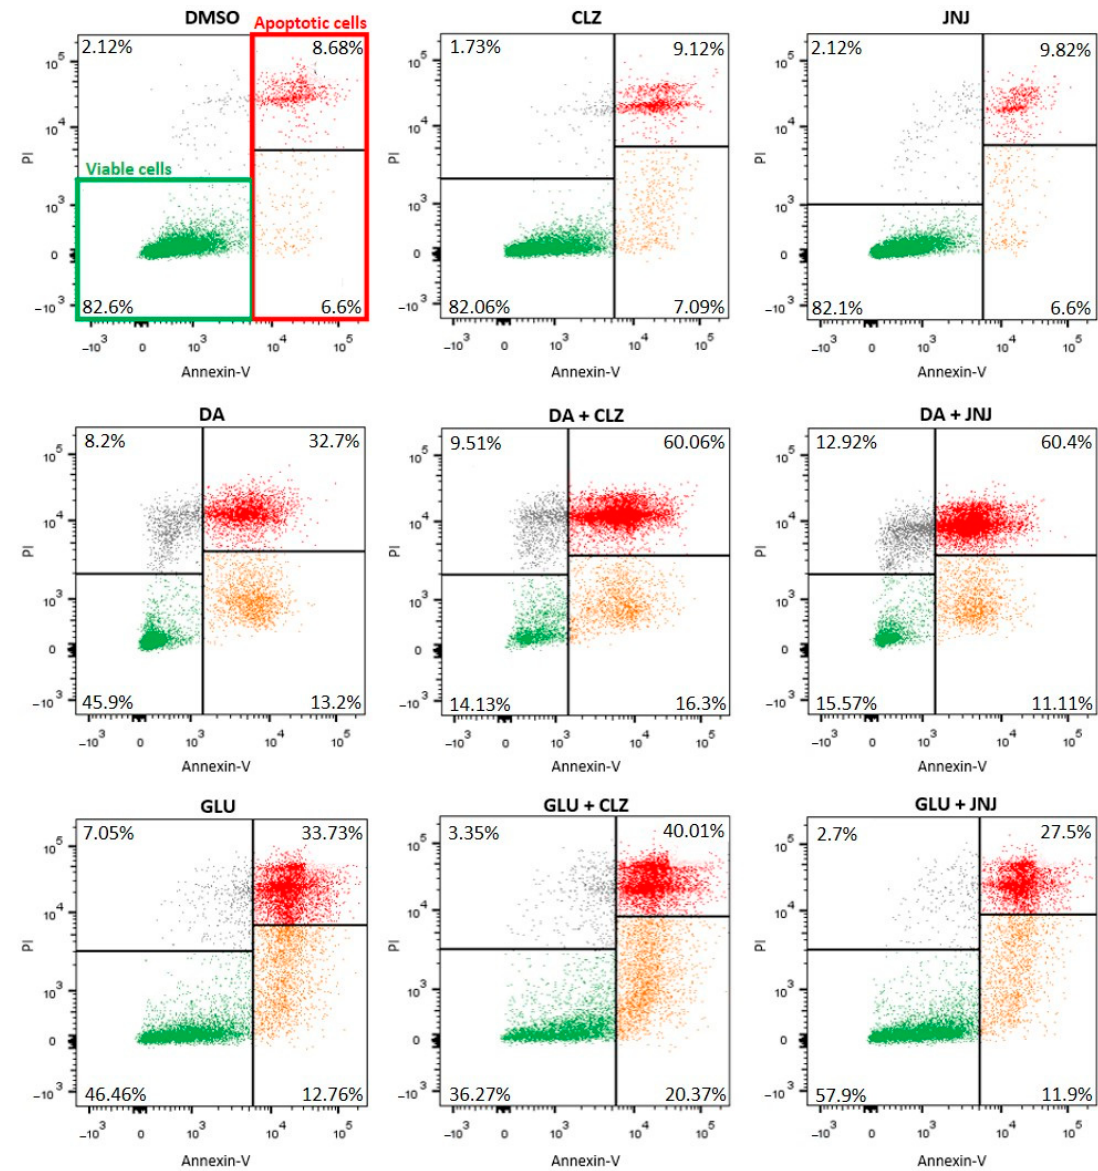
Figure 3. Representative plots showing apoptotic cell death as assessed by cytometric analysis using annexin-V/propidium iodide (PI). Dot plots represent typical results after SK-N-SH incubation with clozapine (CLZ) and JNJ-46356479 (JNJ) at the highest concentrations (25 µ M) alone or in combination with dopamine (DA) at 200 µ M or glutamate (GLU) at 160 mM. The fluorescence intensity from PI-stained cells is indicated on the y -axis, and the fluorescence intensity from cell-bound annexin-V-FITC is indicated on the x -axis. Live cells were negative for both annexin-V and PI (annexin-V–/PI–) (green cell population in the lower-left quadrant indicated by a green gate in the first representative plot), and apoptotic cells were positive for annexin-V (lower- and upper-right regions indicated by a red gate in the first representative plot). Among the dead cell population, cells positive for annexin-V and negative for PI (annexin-V+/PI − ) were undergoing the early stages of apoptosis, in which the plasma membrane is still intact, and exclude PI (orange population in the lower-right quadrant). In the late stages of apoptosis and necrosis, dying cells can no longer exclude PI, and the upper-right region displays both annexin-V-positive and PI-positive (annexin-V+/PI+) cells (red cell population). Annexin-V-negative and PI-positive (annexin-V − /PI+) cells in the upper-left region are necrotic cells (grey population).